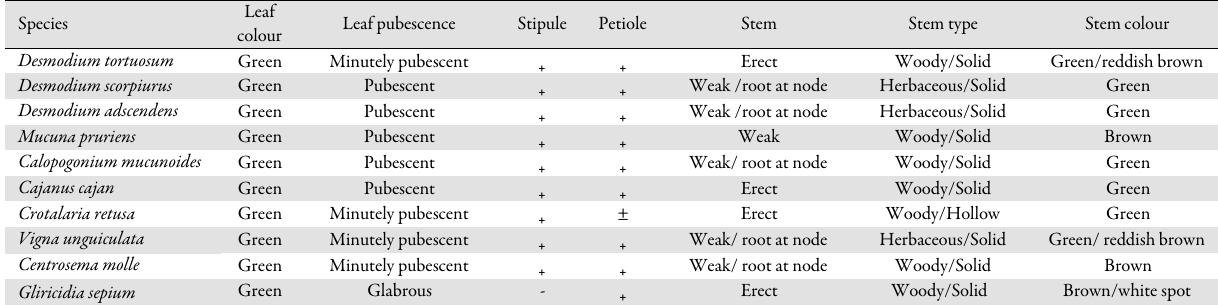
Table 1. Summary of the qualitative morphological traits of the studied species of the subfamily Papilionoideae (Contd) Leaf Species